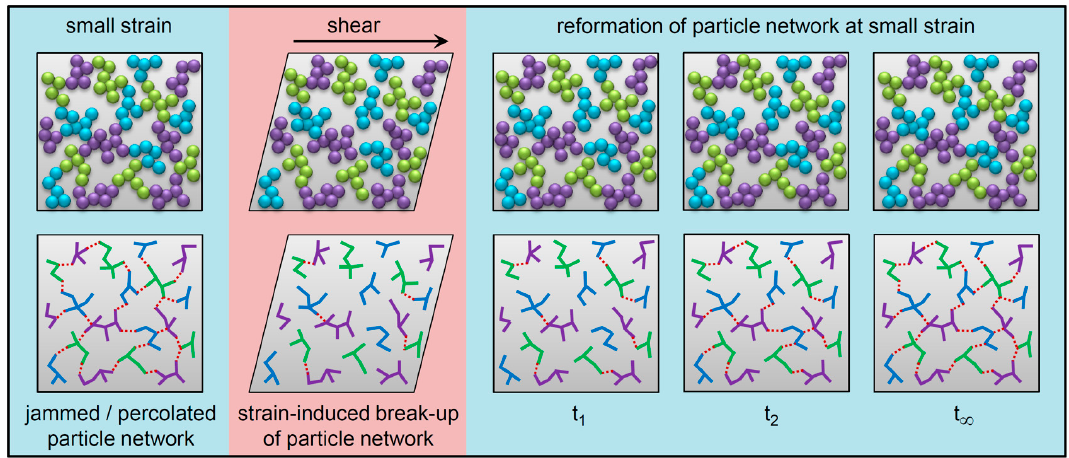
Figure 1. Illustration of the effect of shear strain on the particle network in a filled elastomer and the subsequent time-dependent reformation process. The different colored aggregates in the upper diagrams represent fused primary particles, and these aggregates are the smallest dispersible units of nano-structured fillers such as carbon black and precipitated silica. The lower diagrams illustrate the connectivity of the filler network, with solid lines showing fused connections of primary particles within aggregates and dashed lines showing aggregate–aggregate (filler–filler) contacts.